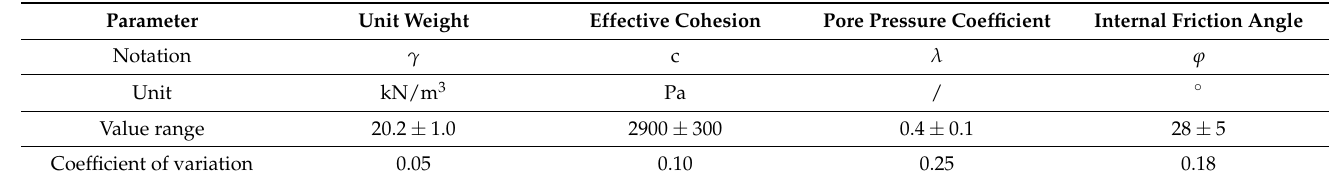
Table 1. The value of the soil parameters used in the Monte Carlo simulation.